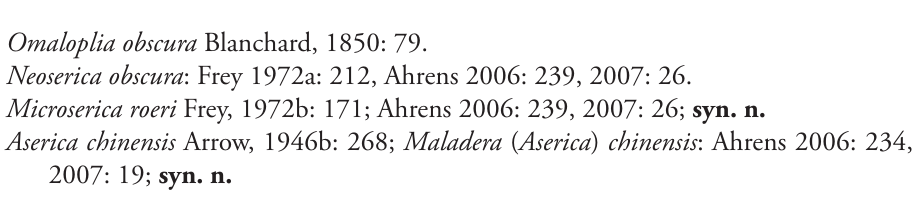
Figs 2E–H, 6 Omaloplia obscura Blanchard, 1850: